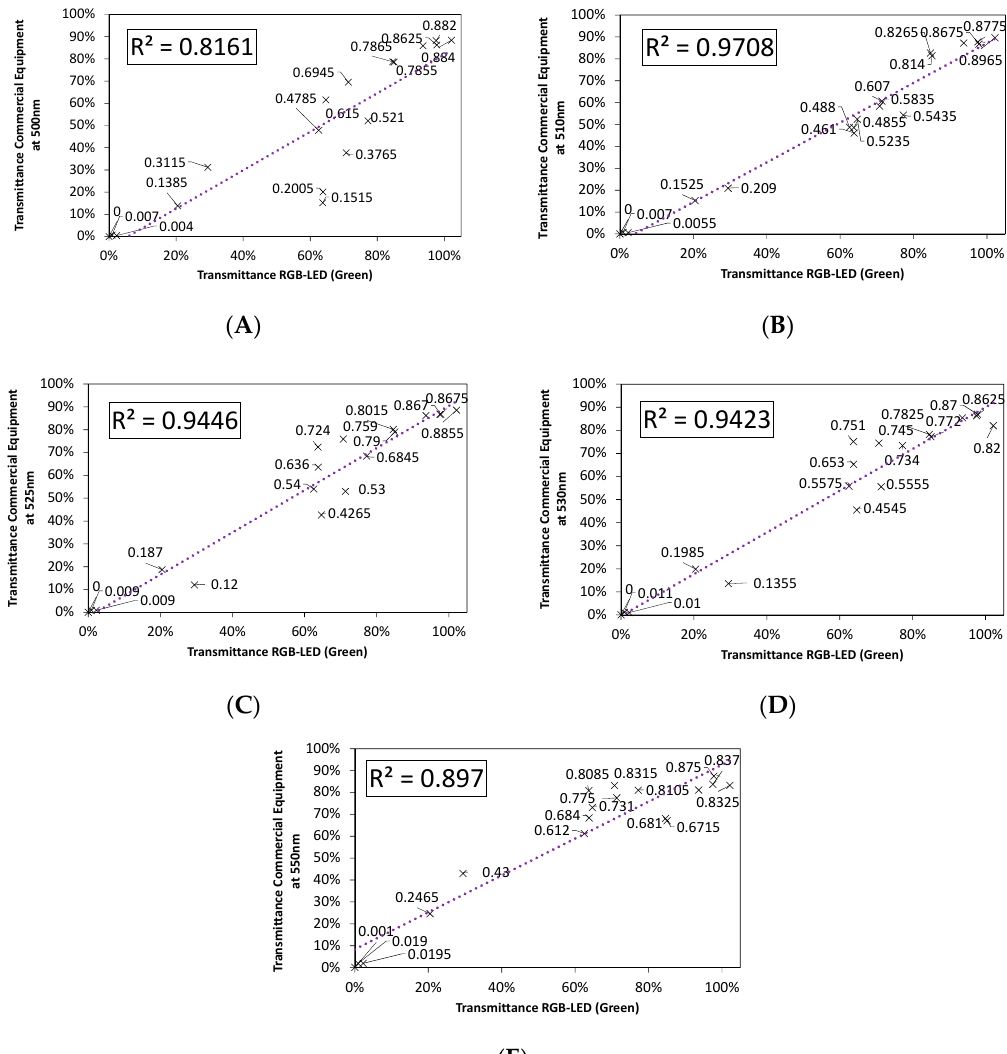
Figure 8. Comparison of the fit for the emission spectrum of the red LED to: ( A ) 600 nm, ( B ) 610, ( C ) 625 nm- λ Peak, ( D ) 630 nm, and ( E ) 645 nm.